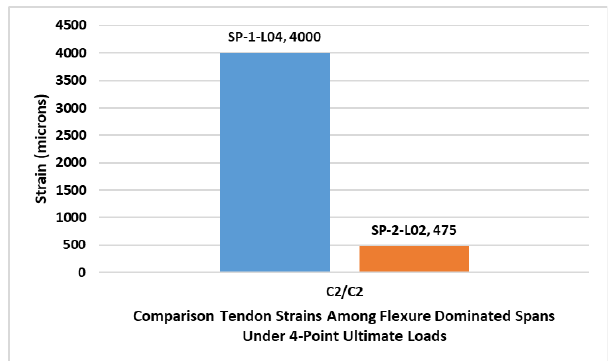
Figure 49. Comparison of maximum tendon strains recorded under four-point ultimate loads be- tween specimen SP-1 and SP-2.